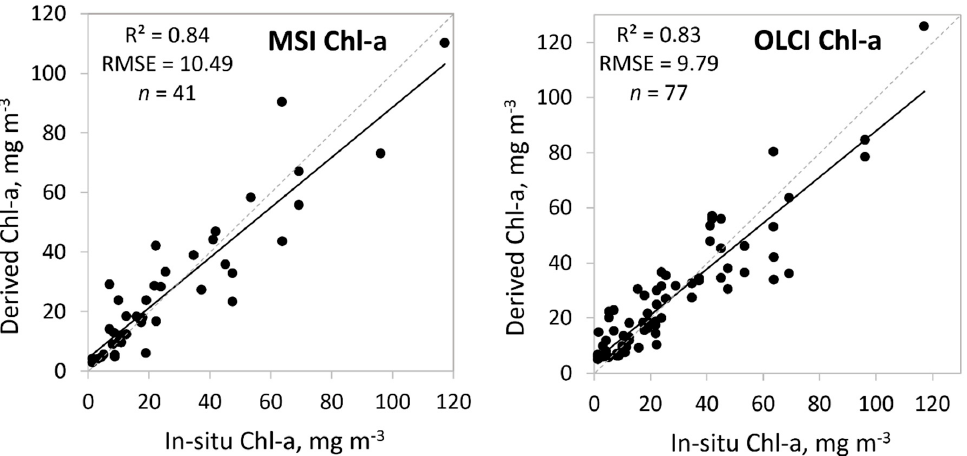
Figure 6. Correlation between in-situ and satellite derived chlorophyll-a (Chl-a, mg m − 3 ) from MSI and OLCI based on the optical water types (OWTs). Also, R 2 , RMSE, and the number of samples ( n ) are given. Table 3. The best MSI and OLCI top-of-atmosphere (TOA) band ratios and their R 2 and RMSE for